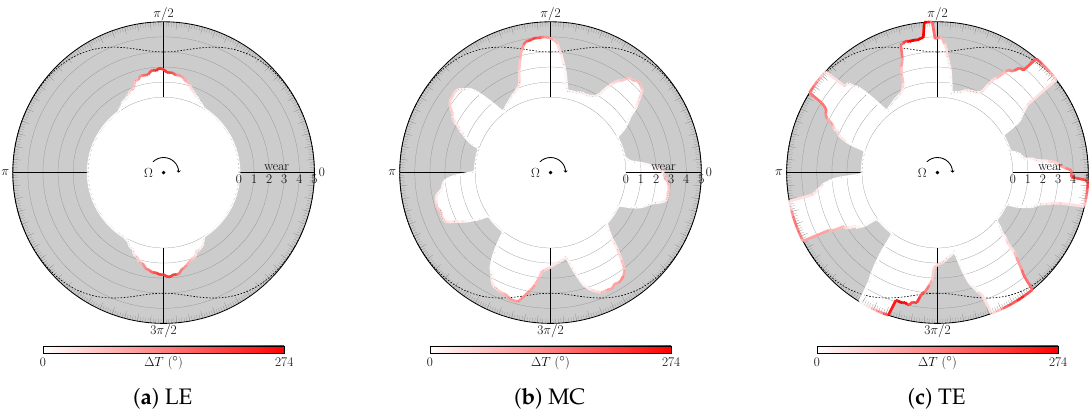
Figure 17. Numerical wear and temperature profiles for simulations on the LP compressor’s